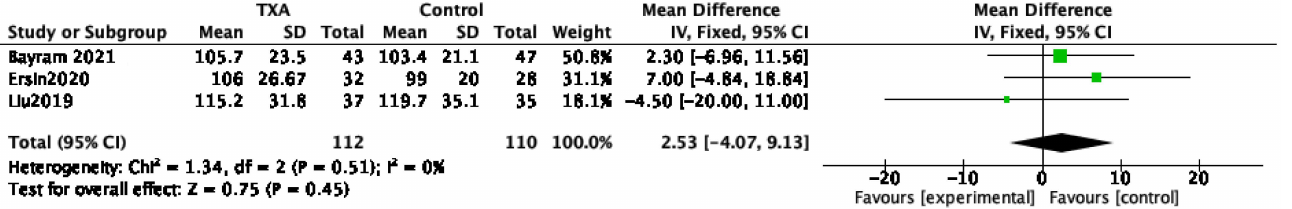
Figure 6. Forest plot and meta-analysis of operation time.The centre of each square represents the weighted mean differences for individual trials, and the corresponding horizontal line stands for a 95% confidence interval. The diamonds represent pooled results